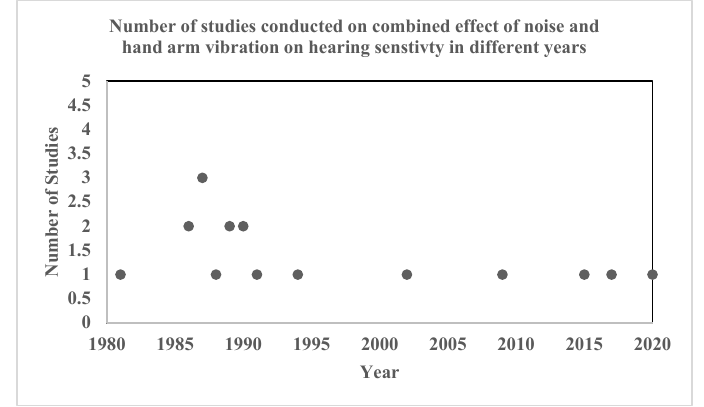
Figure 2. Number of studies conducted by year .